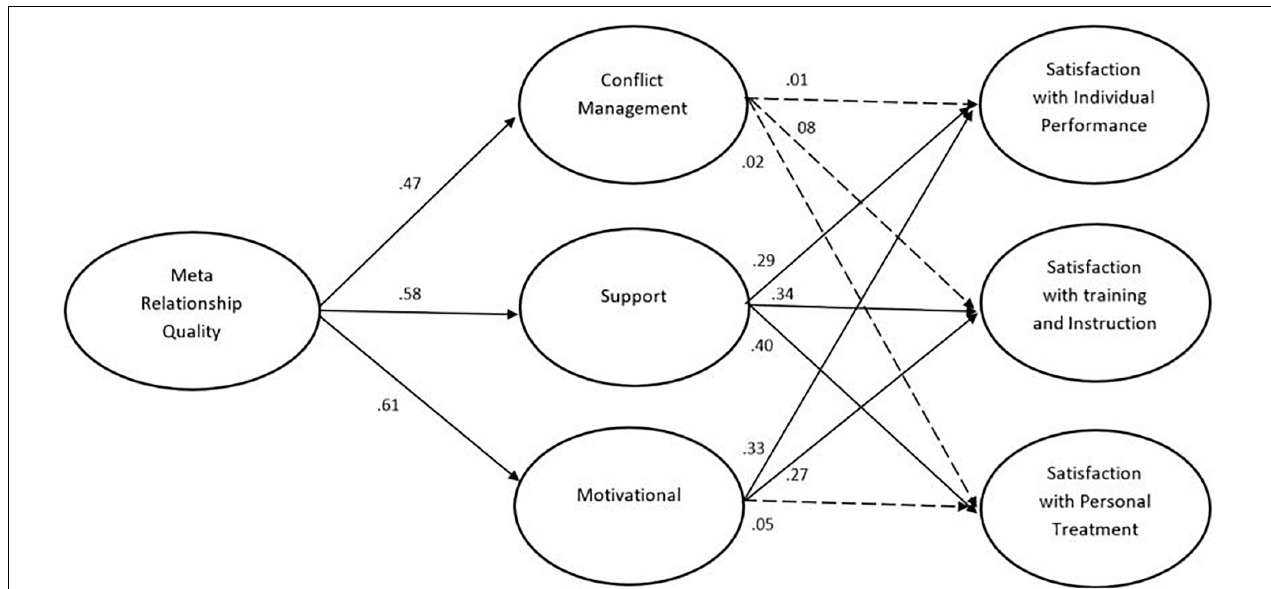
FIGURE 2 | The mediation model describing mediation of relational maintenance strategies in the link between the meta perspective of coach-athlete relationship quality and athlete satisfaction. Only standardized co-efficients are presented. The estimates between relationship quality and sport satisfaction was omitted for